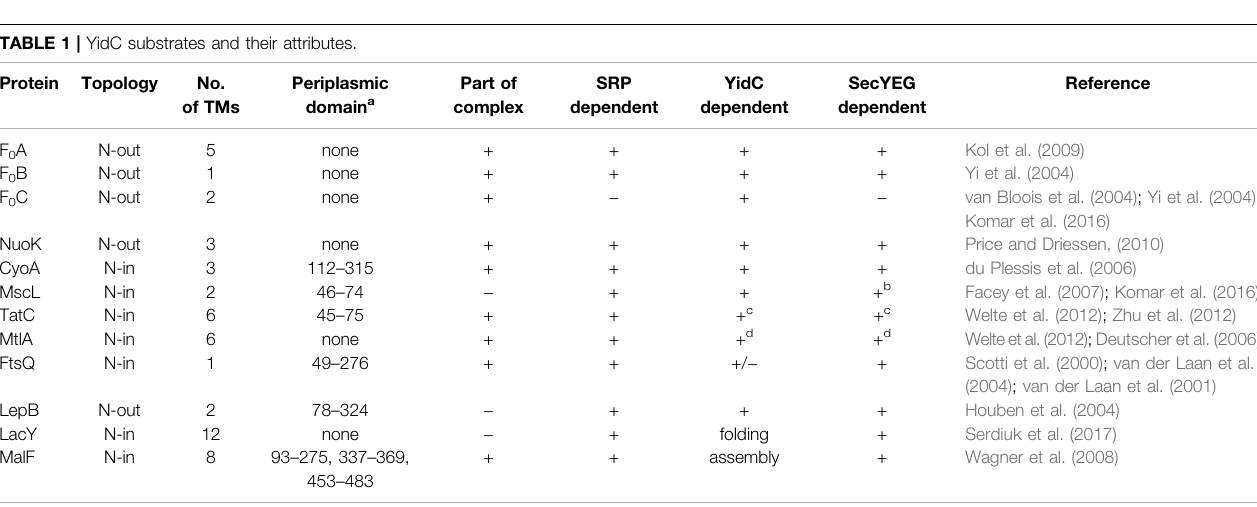
TABLE 1 | YidC substrates and their attributes. Protein